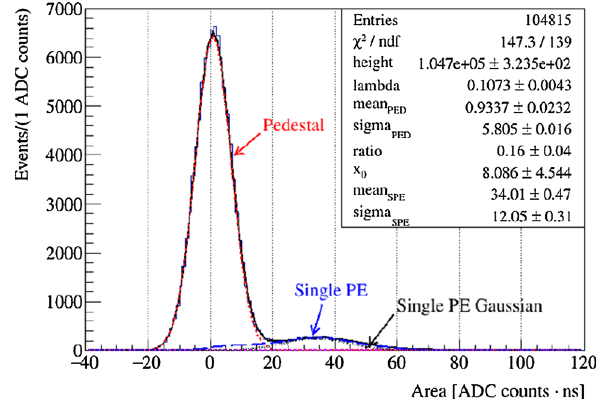
Fig. 4 Two hundred consecutive waveforms from the bottom PMT overlapped with each other